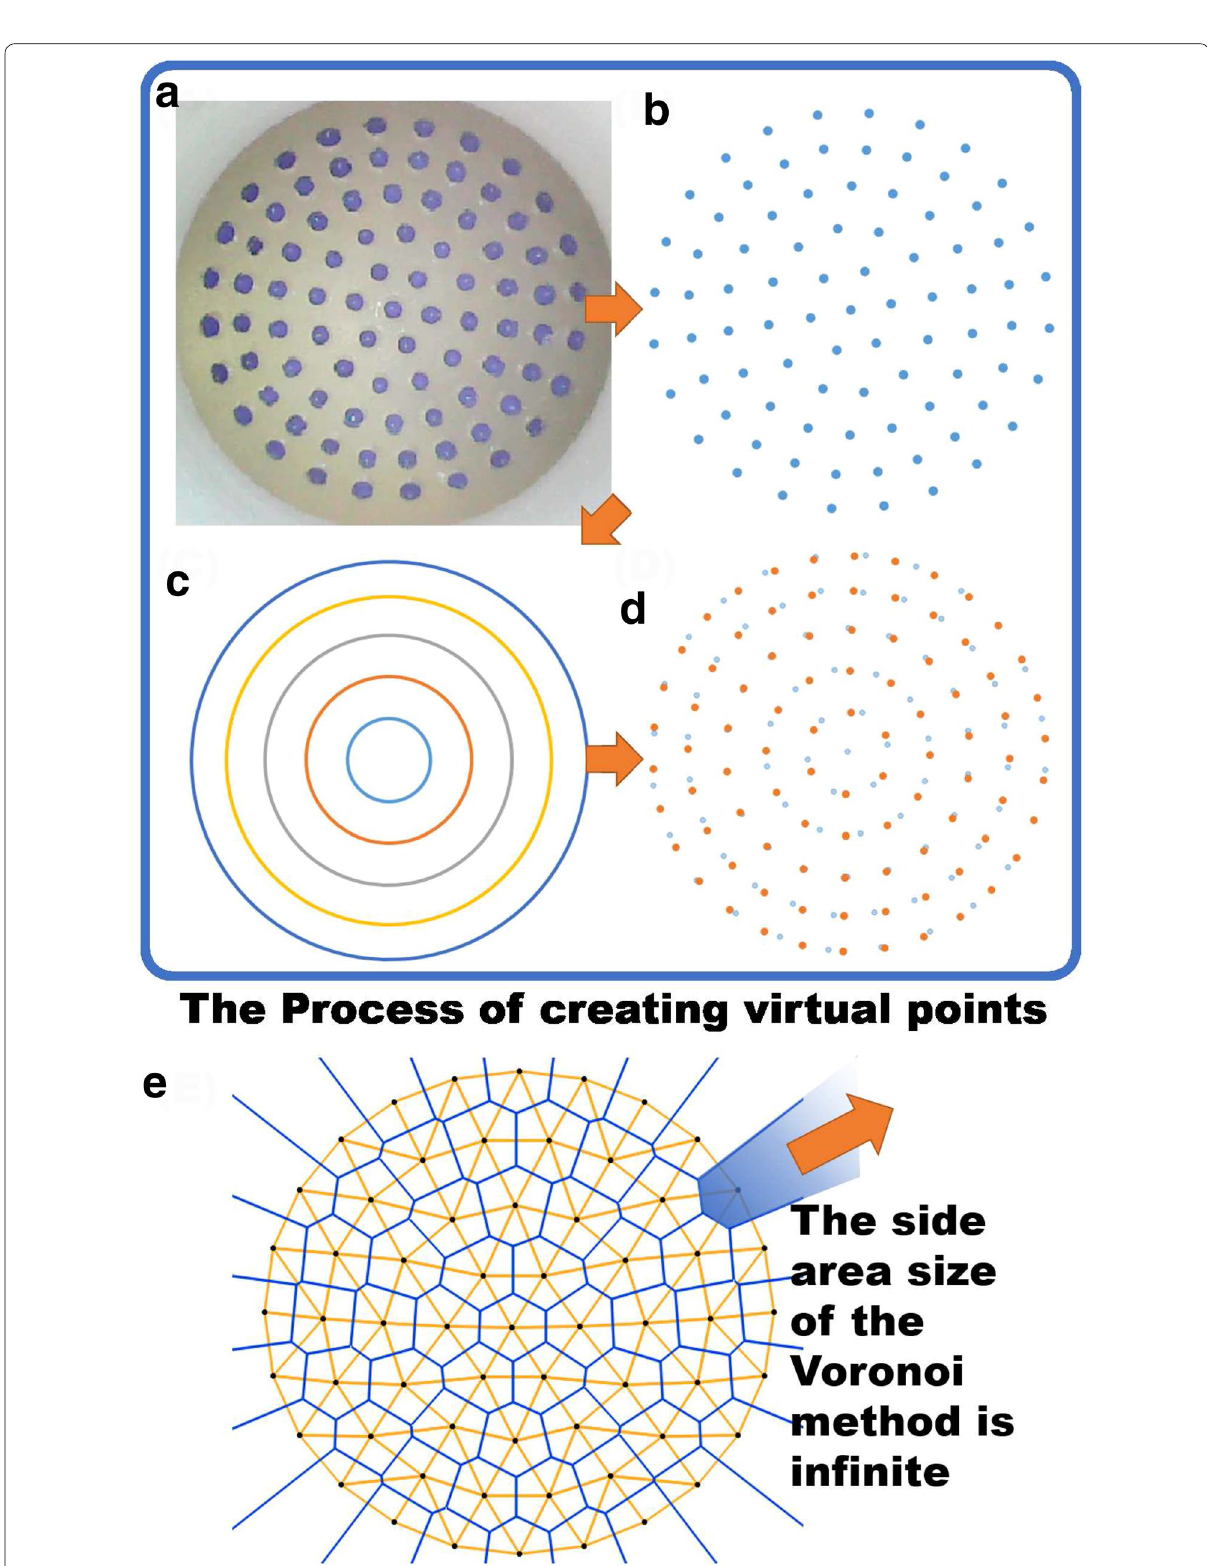
Fig. 5 Process for creating a new virtual point: a Original image received from a USB camera. b Point detected after image processing. c Ellipse fitting based on the detected point. d New virtual points created based on the fitted ellipse (Orange: newly created virtual point, Blue: the original point). e Comparing spatial partitioning results (Blue: the Voronoi space division, Orange: the Delaunay